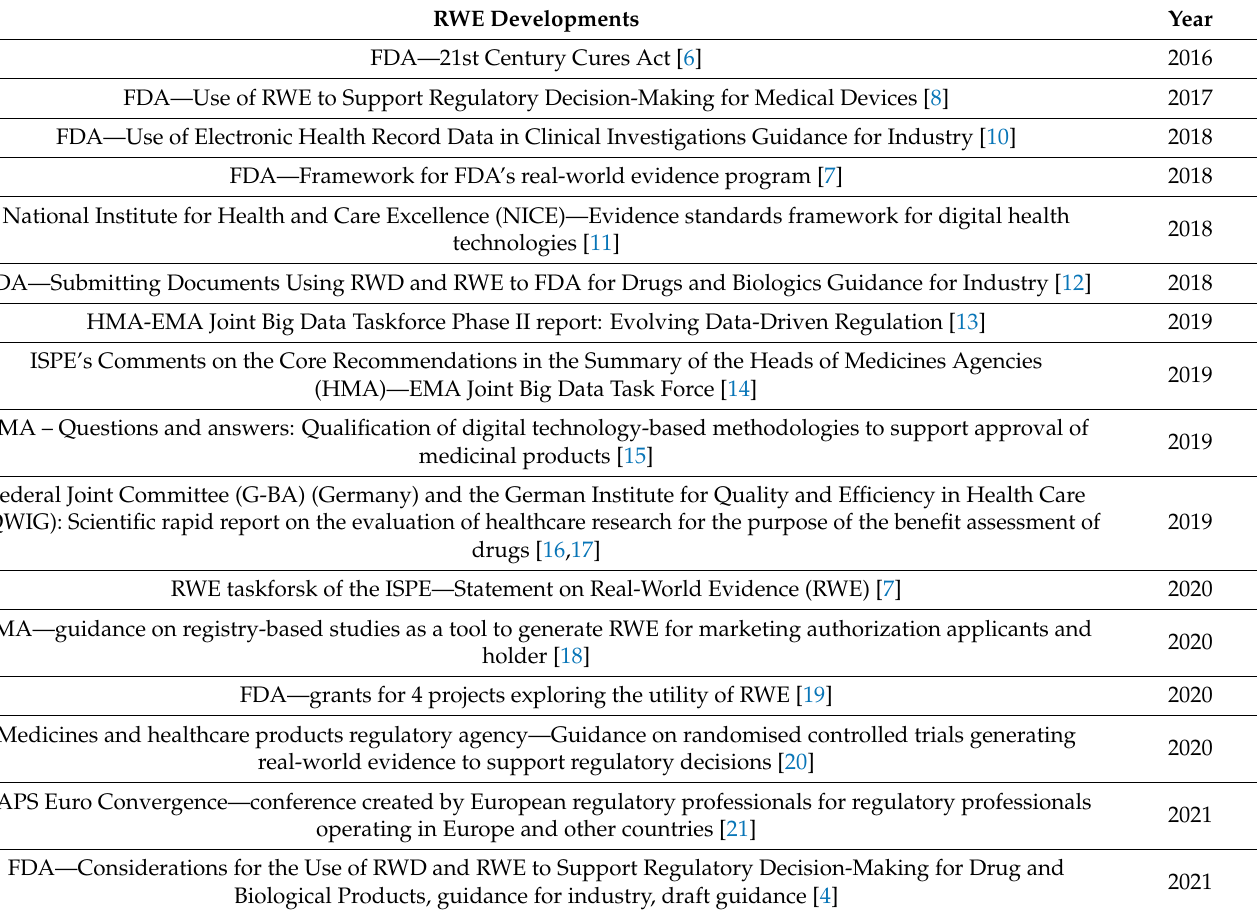
Table 1. RWE developments in the international context for regulatory